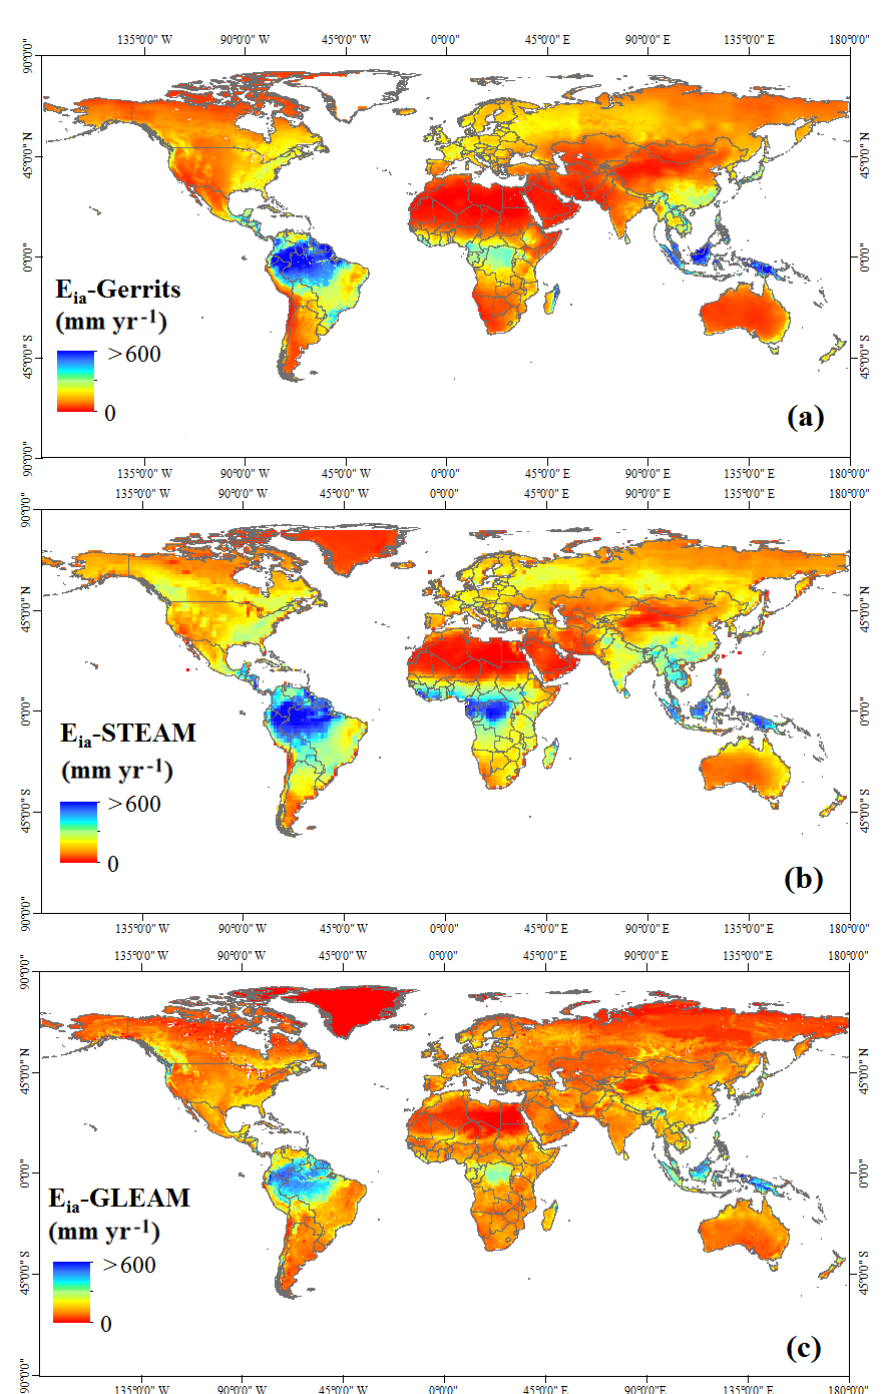
Figure 3. Simulated mean annual interception by (a) Gerrits’ model, (b) STEAM, and (c)